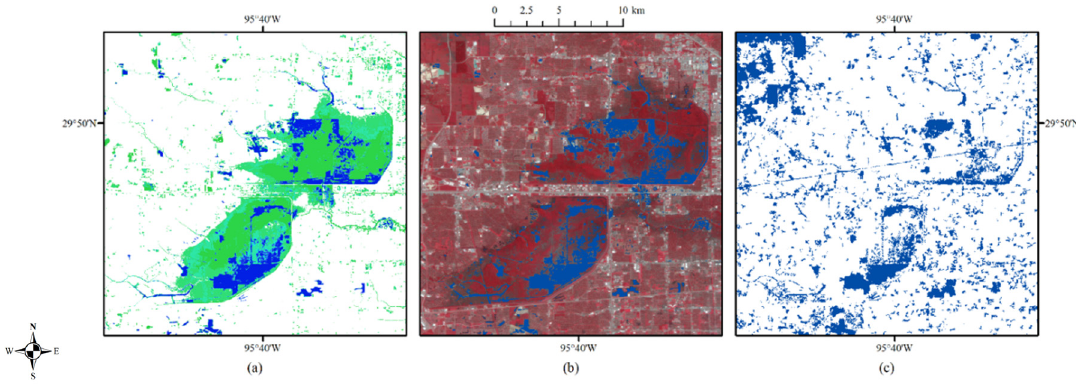
Figure 12. Enlarged site (B): inundation probability ( a ), the corresponding optical image on 1 September ( b ), and ( c ) FEMA flood map, with water shown in blue.